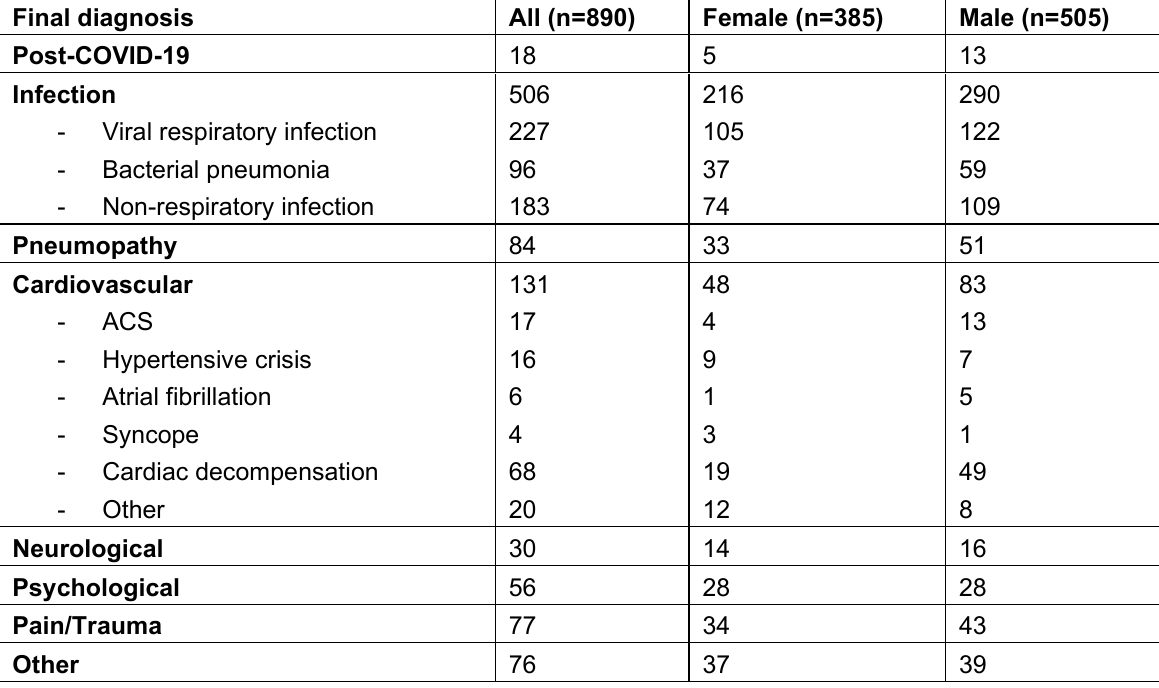
Table S2: Final diagnosis in controls. Patients can be adjudicated to more than one diagnosis. Final diagnosis All